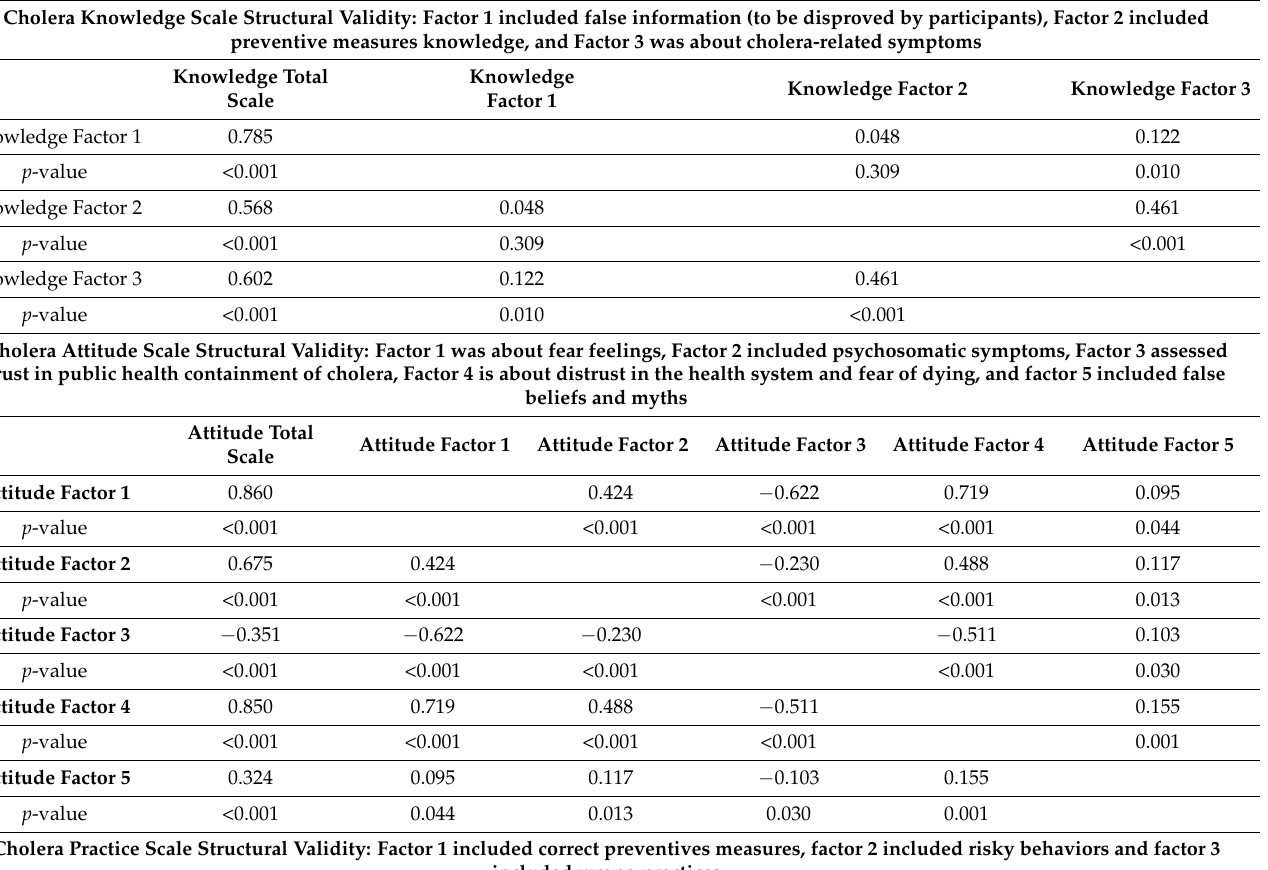
Table 4. Cholera KAP scales structural and